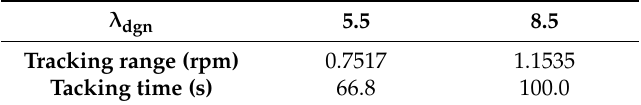
Figure 3. Trajectories of the wind turbines with different λ dgn excited by a same step wind speed. Table 1. Response of the wind turbines with different λ dgn excited by a same step wind speed.